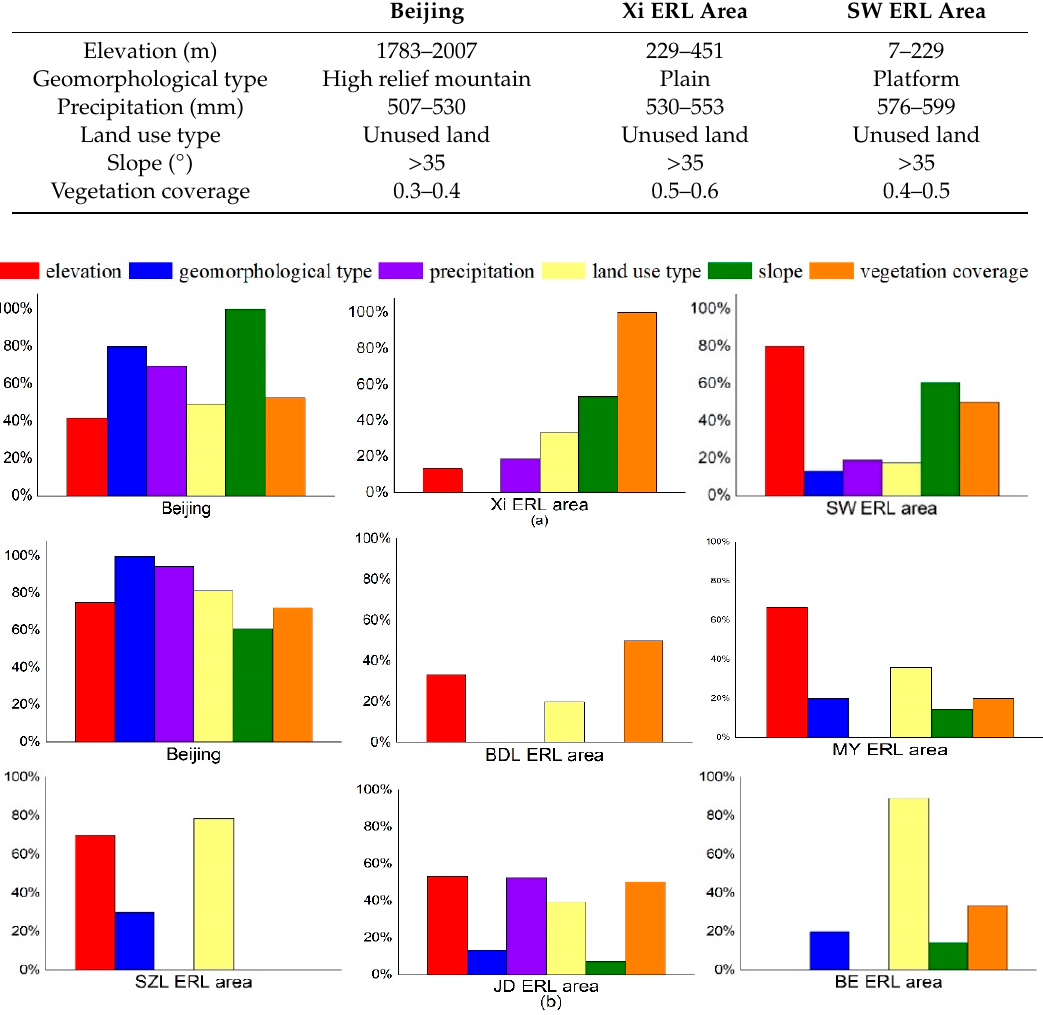
Figure 4. The percentage of stratification combinations with significant difference in each influencing factor affecting soil erosion ( a ) and water yield ( b ).